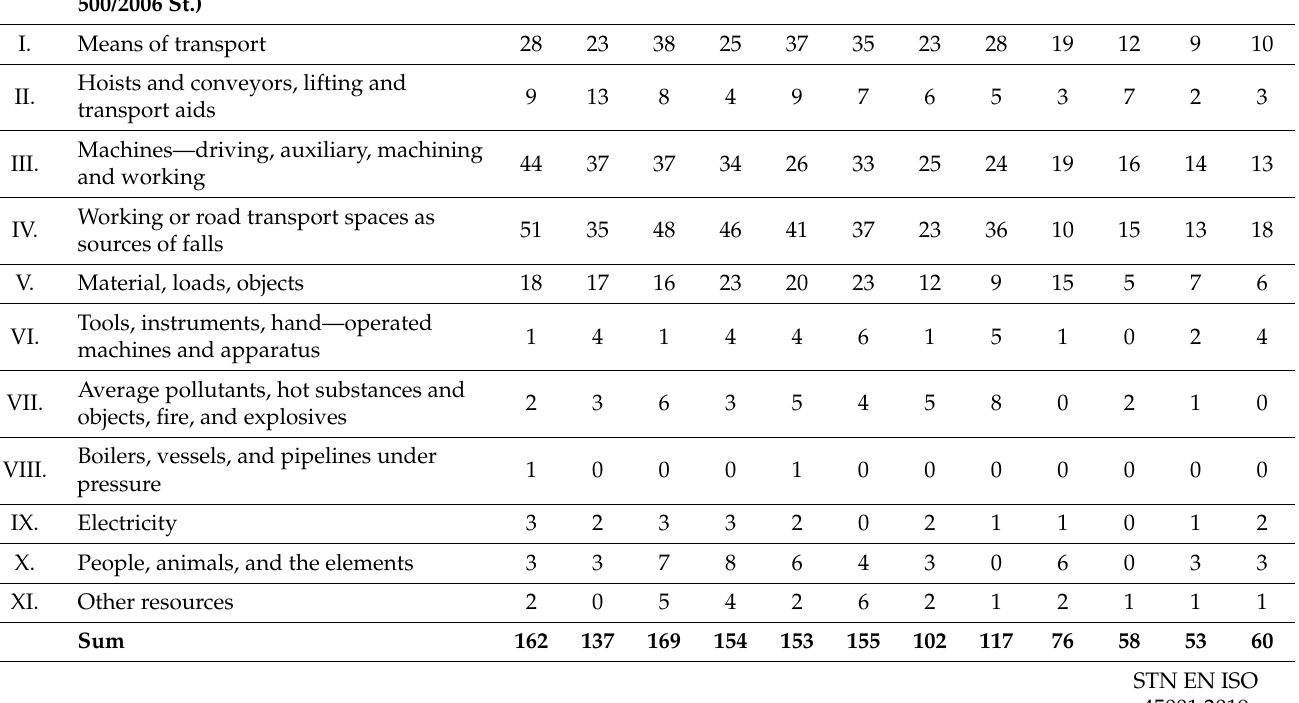
Table 6. Share of main groups of resources in the total number of serious accidents at work in organizations in the years 2010–2021 [31].